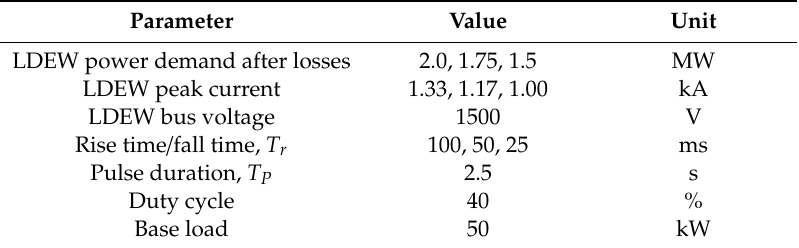
Table 3. Laser directed energy weapon (LDEW) load characteristics